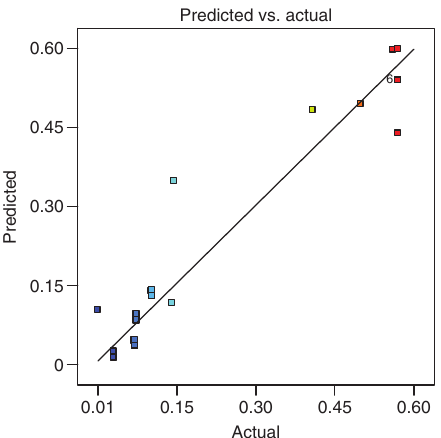
Figure 3: Comparison between the predicted and the observed